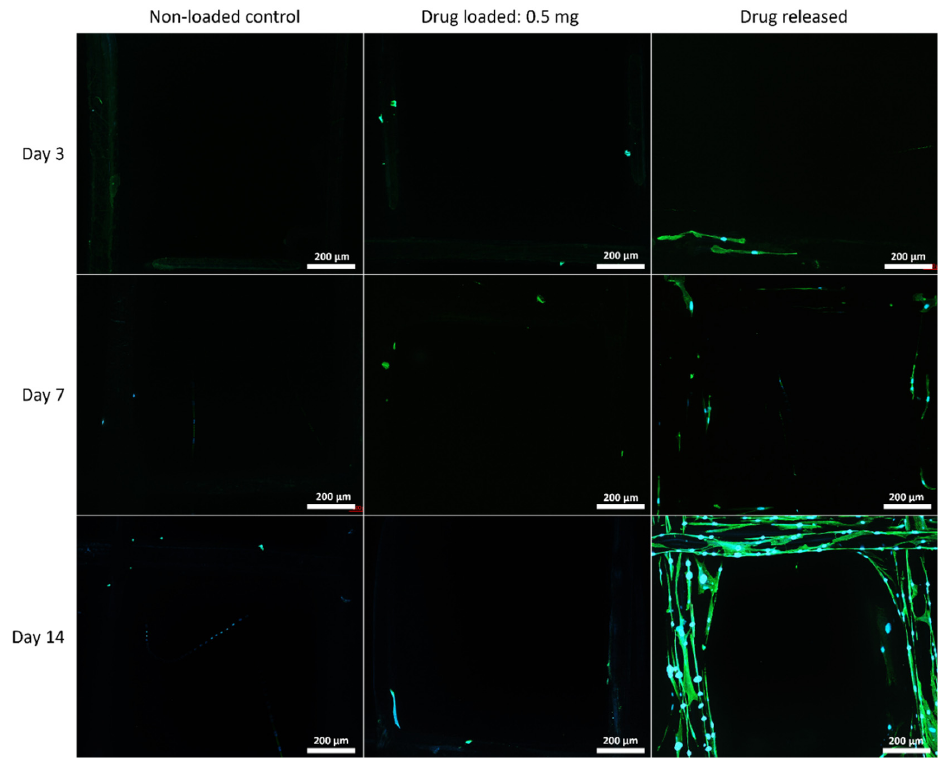
Figure 9. MSC cell morphology on 75:25 mesh groups at all time points. Cell nuclei are shown in blue and cytoskeleton shown in